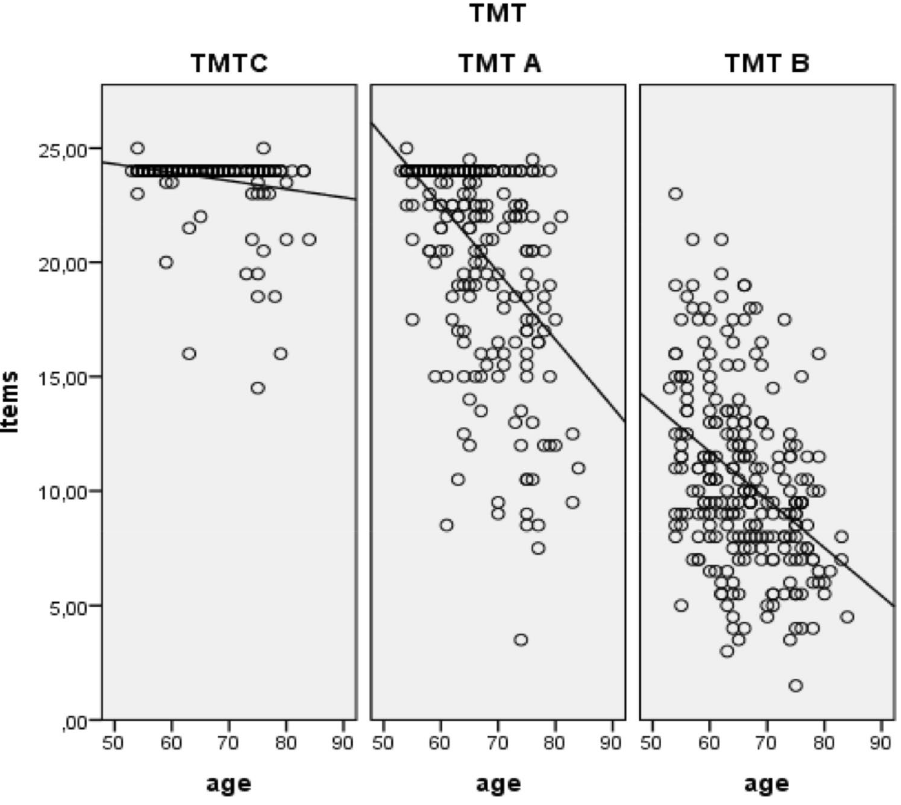
Figure 6. Negative linear relationship between age and number of completed